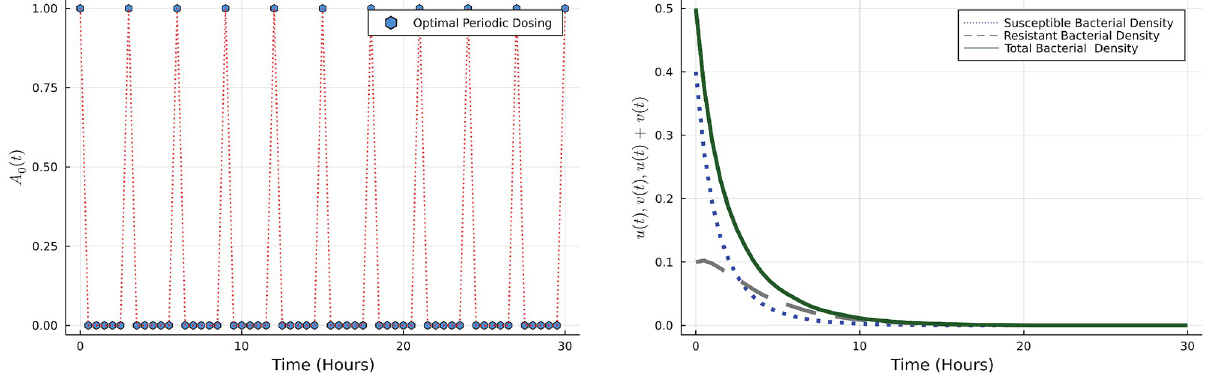
Fig 2. The left figure shows the antibiotic usage throughout the time when λ 4 = − 0.1057, λ 5 = − 0.0861. The right figure shows the success of the treatment for 0 < t < 30 h when λ 4 = − 0.1057 < 0 and λ 5 = − 0.0861 < 0.